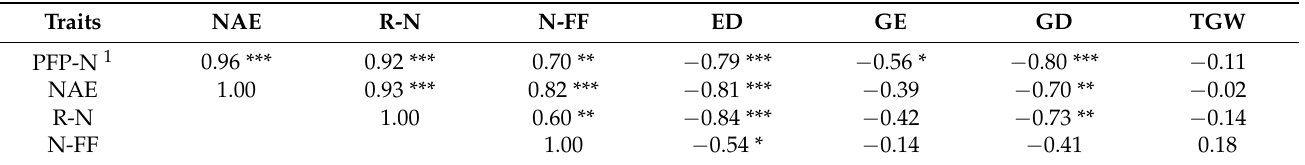
Table A3. Matrix of correlation indices for nitrogen efficiency indices and yield components, n =